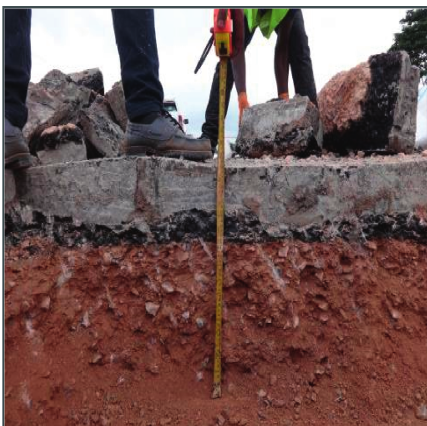
Figure 5: Test pit at the rutted section of the